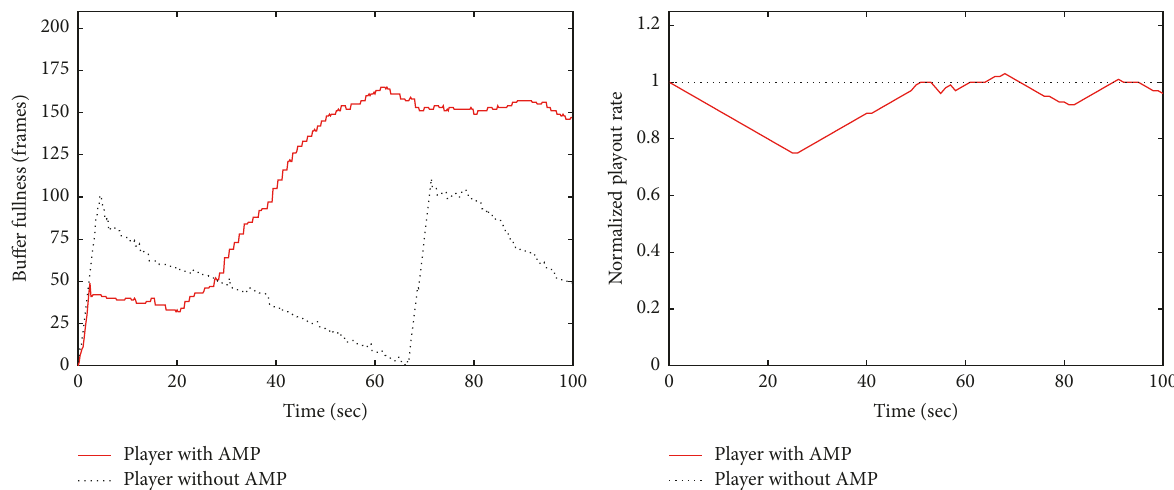
Player with AMP Player without Figure 11: Comparison of buffer fullness and normalized playout rates between systems with and without AMP (cross-traffic rate = 6